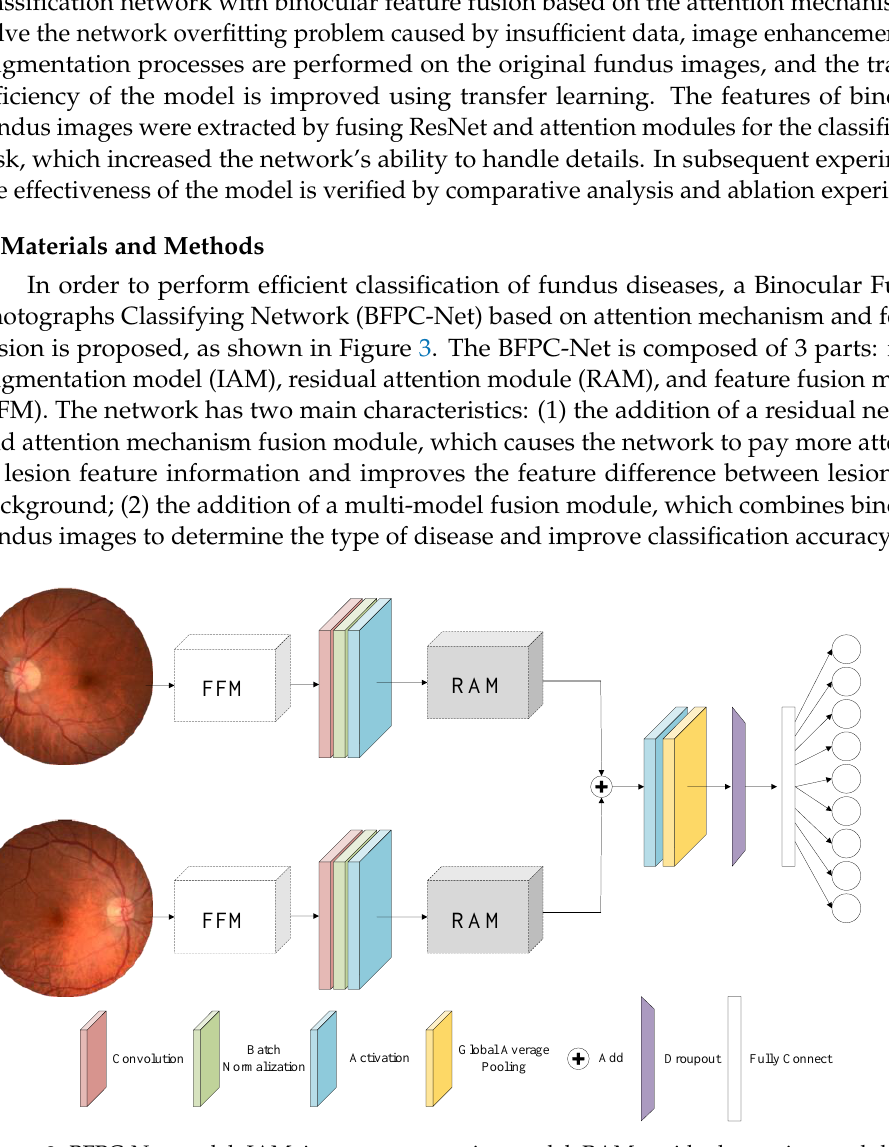
Figure 3. BFPC-Net model. IAM: image augmentation model; RAM: residual attention module; FFM: feature fusion module.